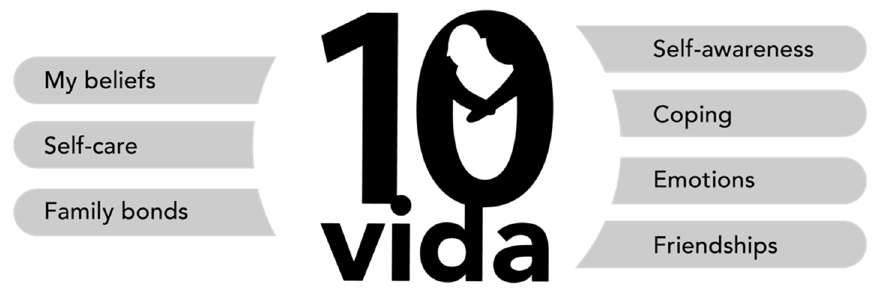
Table 2. 10Vida program summary. Sessions and objectives.